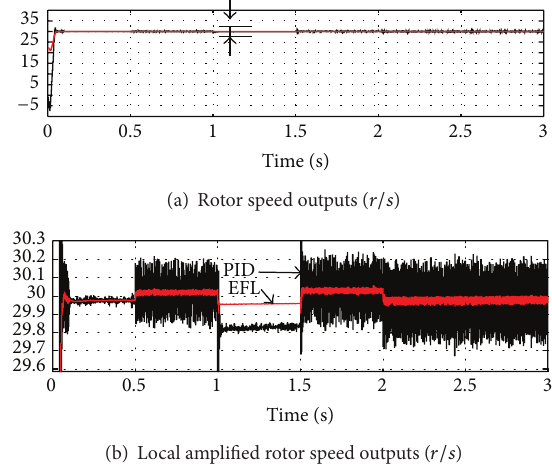
Figure 9: Comparison of torque outputs under different controllers with respect to the same input. Figure 10: Comparison of rotor speed outputs under different